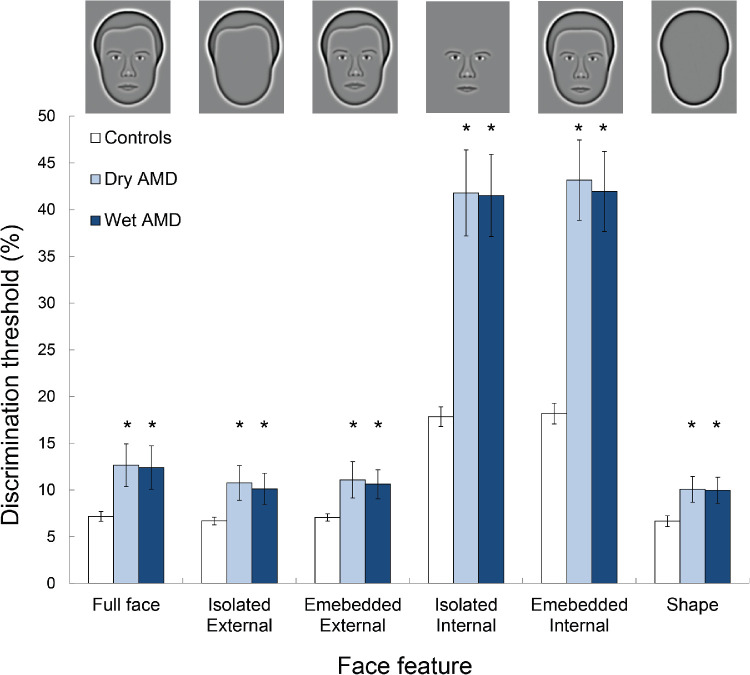
Mean discrimination thresholds for each group. Icons illustrate the feature being tested. Error bars represent 95% confidence intervals. Asterisks indicate significant difference in discrimination thresholds between AMD participants and controls (pairwise comparisons; P < 0.05).